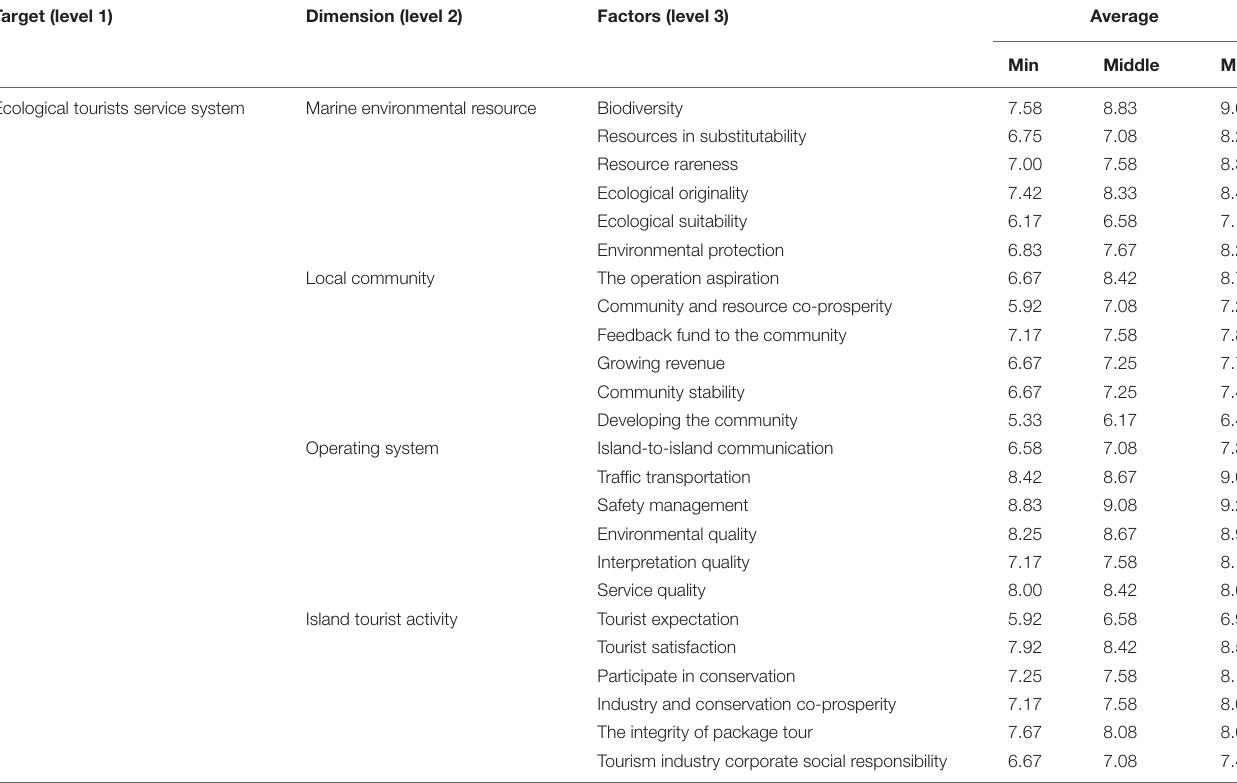
TABLE 2 | The average value of ecotourism service system indicators in the Penghu National Scenic